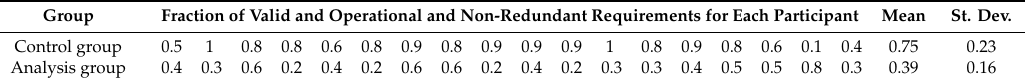
Table 10. Fraction of valid, operational, and non-redundant requirements. Fraction of Valid and Operational and Non-Redundant Requirements for Each Participant Mean St.